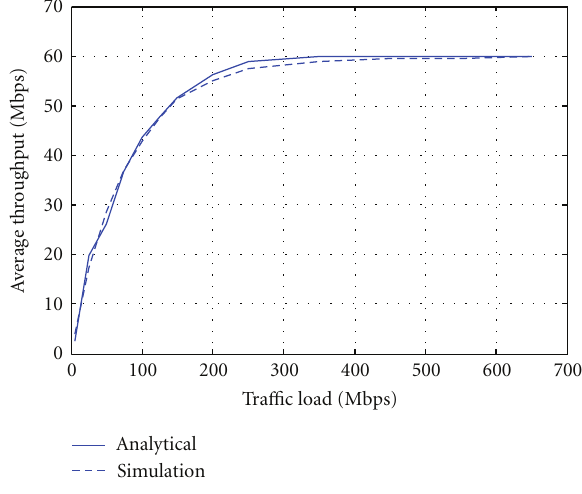
Figure 4: Average throughput versus tra ffi c load.